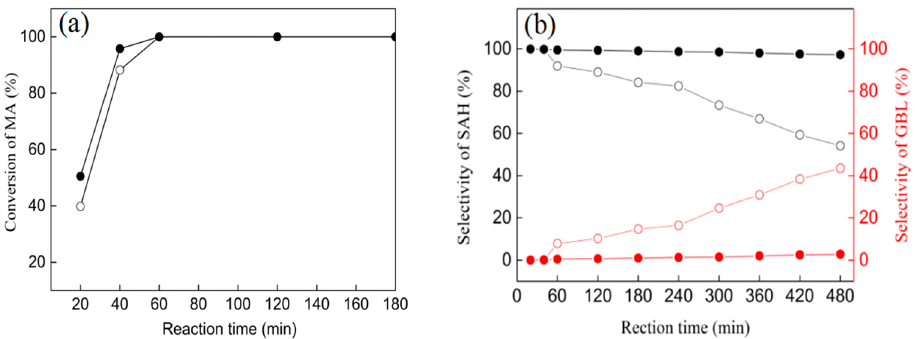
Figure 8. The MA conversion ( a ) and selectivity of SA and GBL ( b ) over the Ni/ZrO 2 (P) (solid symbols) and Ni/ZrO 2 (H) (open symbols) catalysts at 210 °C under 5 MPa for 480 min.